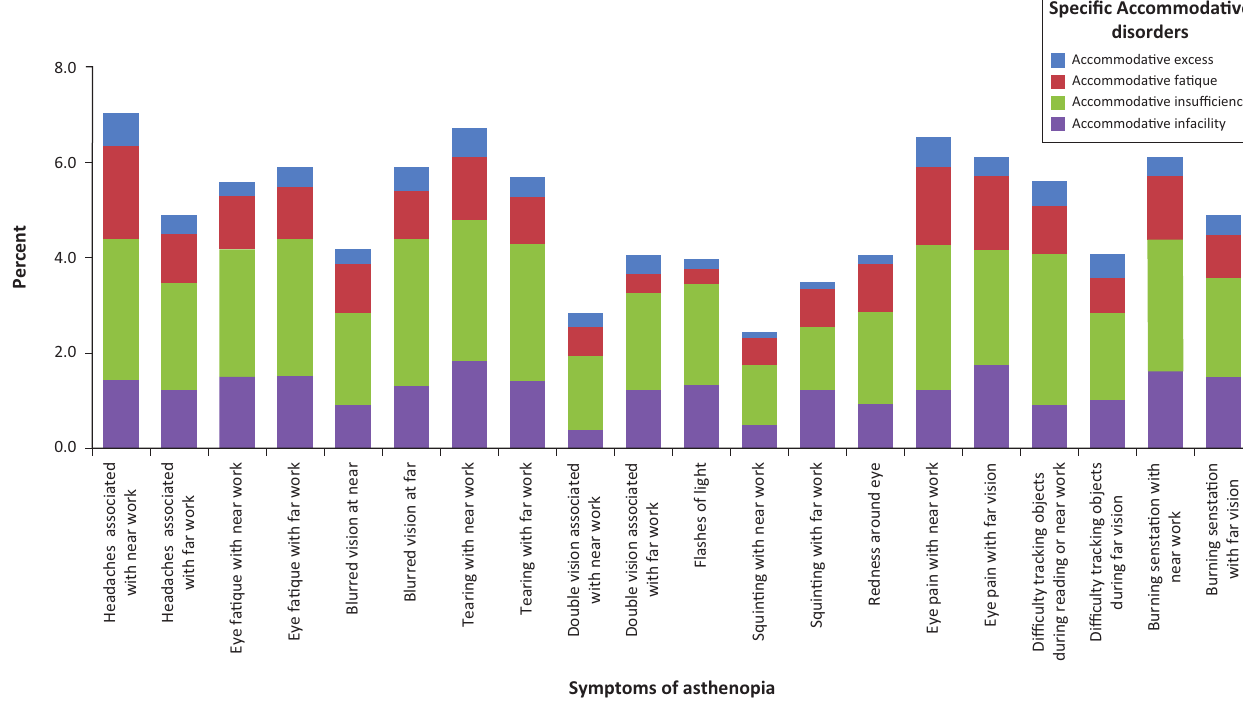
FIGURE 3: Distribution of accommodative disorders among specific asthenopic symptoms. TABLE 3: Association between accommodative disorders in general and asthenopic symptoms in the univariate analysis. Asthenopic symptom Accommodative